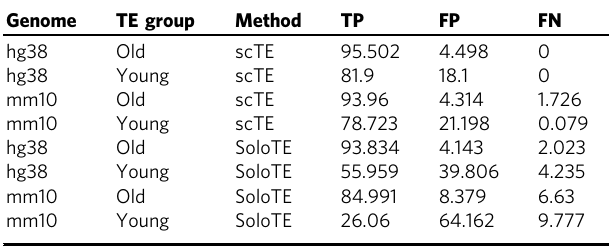
Table 1 Overall expression